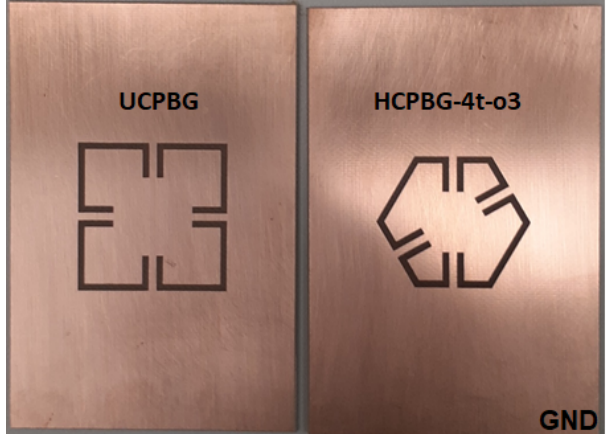
Figure 7. Fabricated UCPBG ( left ) and HCPBG with 4 traces, orientation 3 ( right )-PCB bottom